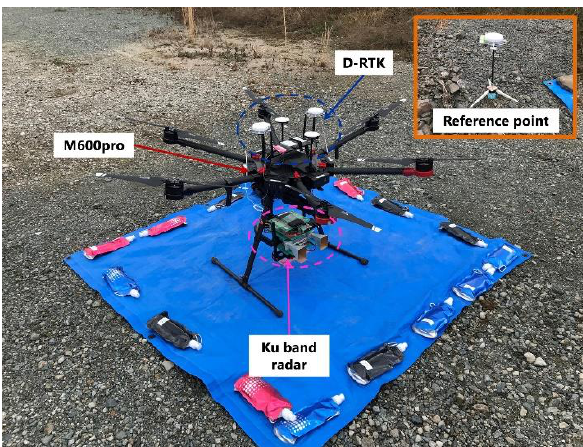
Figure 8. The developed drone-borne SAR